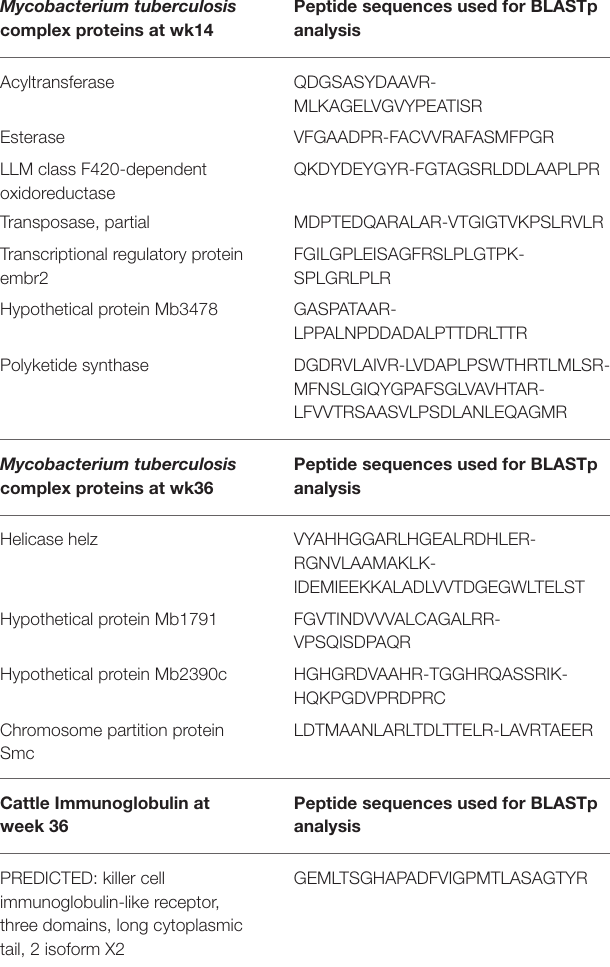
TABLE 2 | List of Mycobacterium tuberculosis complex-specific high confidence proteins at week 14 and week 36 and cattle immunoglobulin at week 36 that passed exclusion